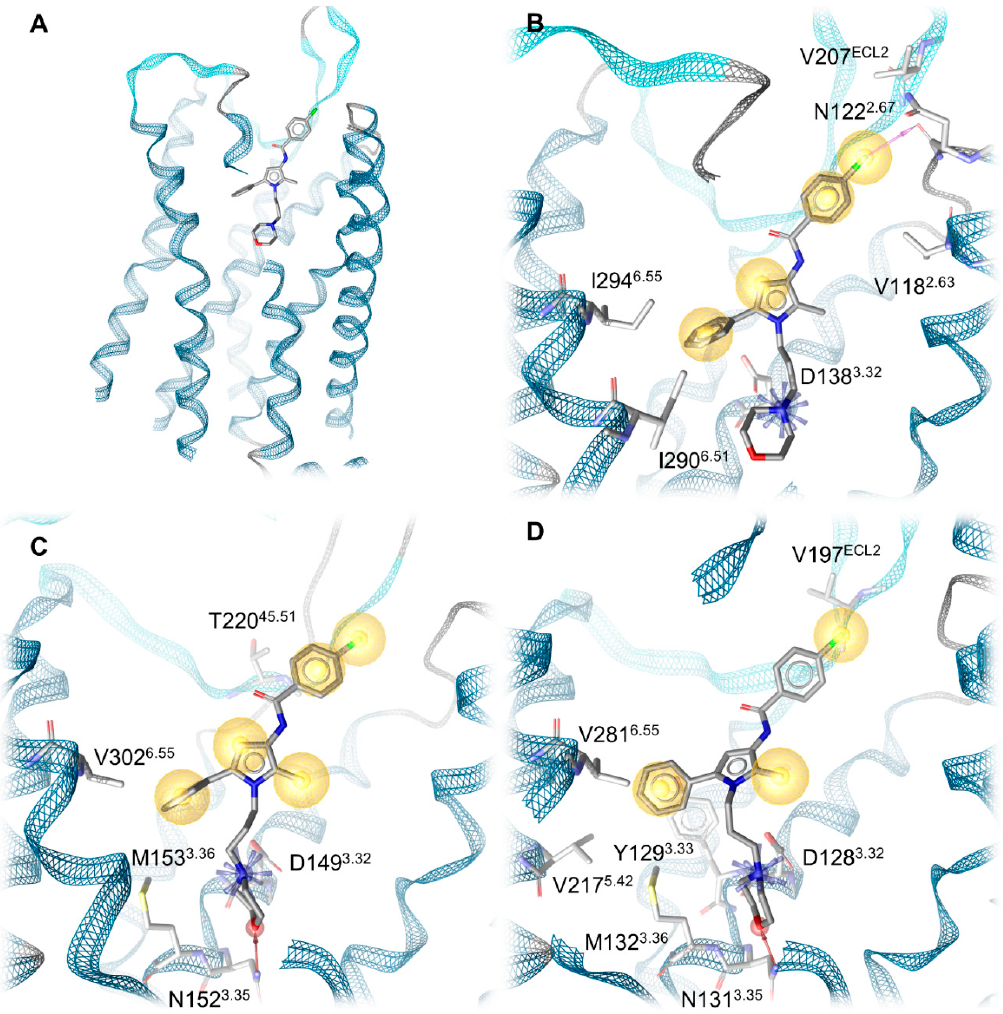
Figure 6. Protein–ligand interactions. ( A ) Global view of Compound A bound to the KOR. ( B ) Protein–ligand interactions at the KOR. ( C ) Protein–ligand interactions at the MOR. ( D ) Protein–ligand interactions at the DOR. Blue stars indicate positive charges, yellow spheres lipophilic contacts, pink arrows halogen bond donors and red arrows hydrogen bond acceptors. The residues 313–319 in the KOR, 314–327 in the MOR and 276–279 as well as 296–307 in the DOR are not shown for better visualization.